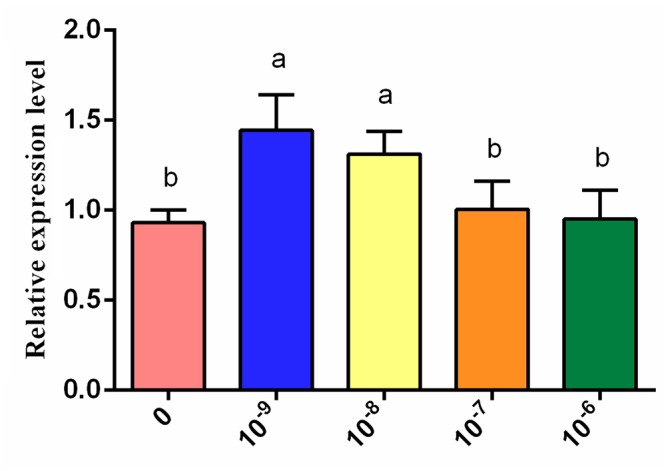
Expression level of the EDNRB2 gene (determined by qRT-PCR analysis) in melanocytes of Xichuan black-bone chickens treated with different concentrations of tyrosine. Data are expressed as mean ± SD (n = 6). The small letters on the top of each bar represents statistical significance. Data with different small letters on each bar are statistically significant (P < 0.05), while data with the same letters are not statistically significant (P > 0.05).